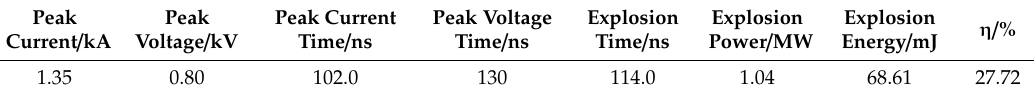
Figure 17. The electric explosion characteristic curve of the energetic film. Table 2. Performance parameters of the electric explosion experiment.